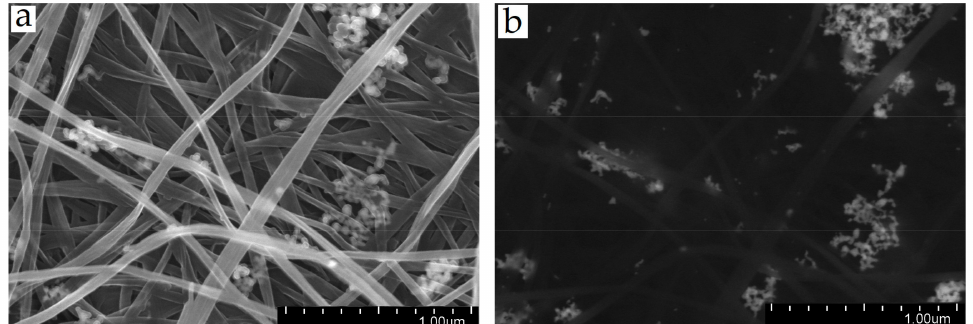
Figure 5. SEM images of the films of BC and composites with Ag NPs: ( a ) Ag NPs/BCF composite; ( b ) Ag NPs/SBCB composite, dark field.